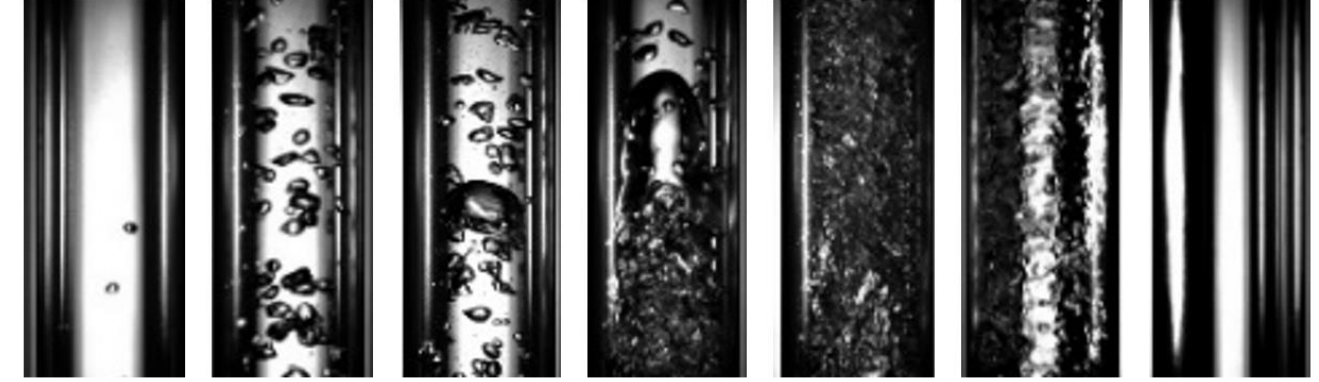
Figure 5. Frame classes ( left to right) : liquid/tiny bubbles, small bubbles, big bubbles, dense bubbles/Taylor bubbles, churn, annular, and mist/vapor.